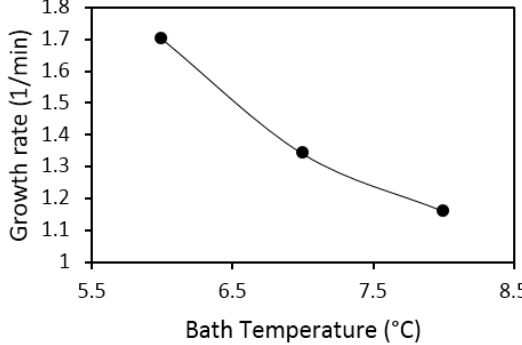
Figure 12. Effect of temperature on gas hydrate growth rate (50 mL water content, 700 rpm stirring rate, 141.4 mL cell).